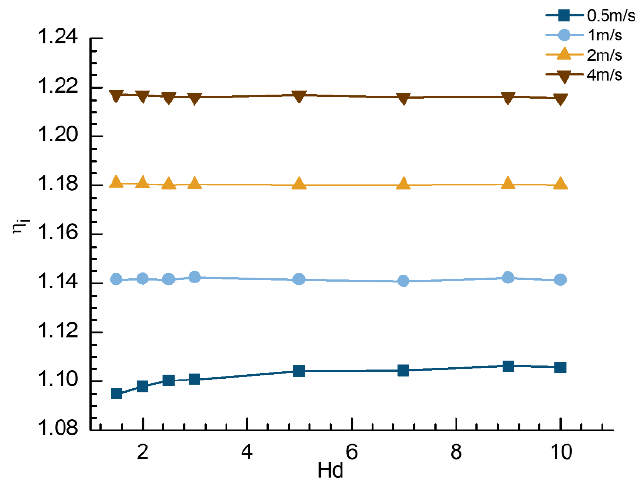
Figure 21. Efficiency of propeller rotation.